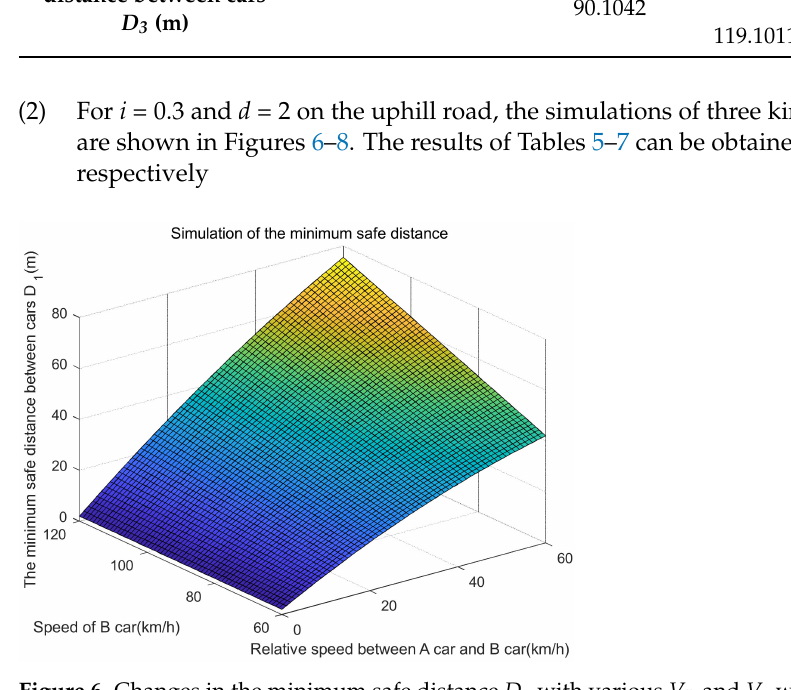
Figure 6. Changes in the minimum safe distance D 1 with various V B and V r when i = 0.3 and d = 2.